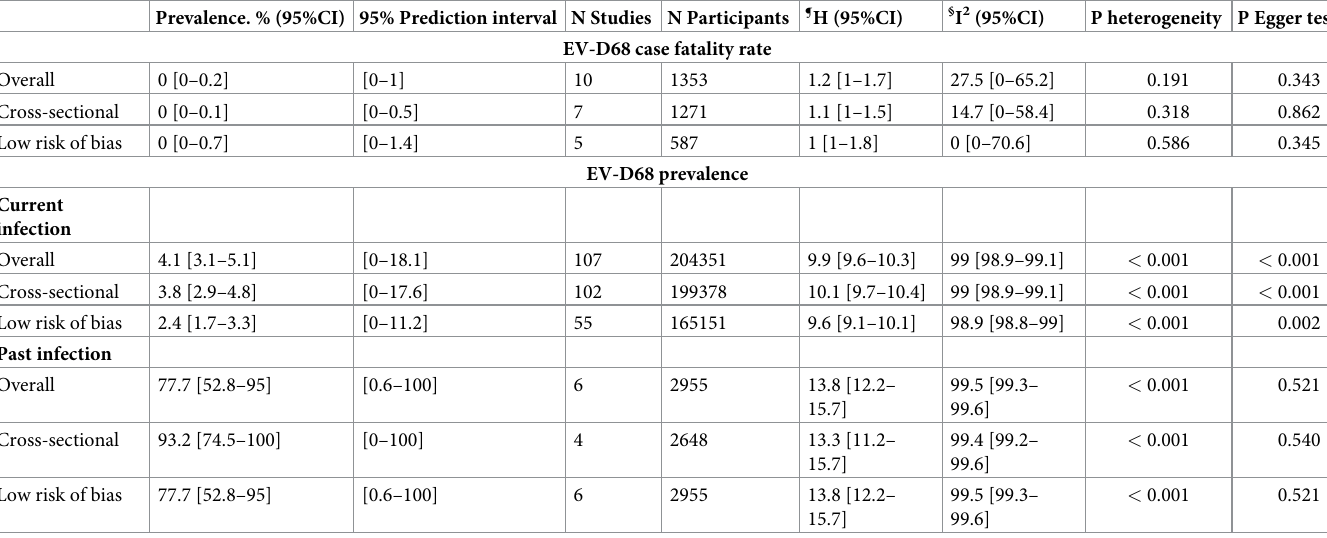
Table 1. Summary of meta-analysis results for global case fatality rate and prevalence of Enterovirus D68 in humans. Prevalence. % (95%CI) 95% Prediction interval N Studies N Participants ¶ H